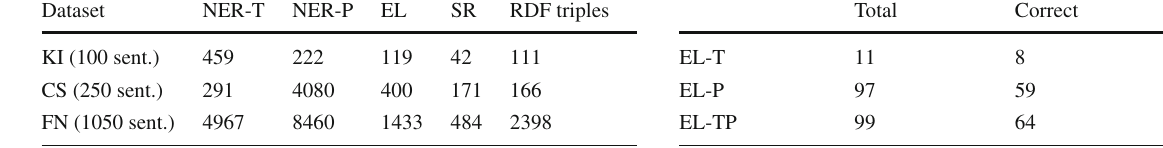
Table 6 Results of the extracted components Dataset NER-T NER-P EL SR RDF triples KI (100 sent.) 459 222 119 42 111 CS (250 sent.) 291 4080 400 171 166 FN (1050 sent.) 4967 8460 1433 484 2398